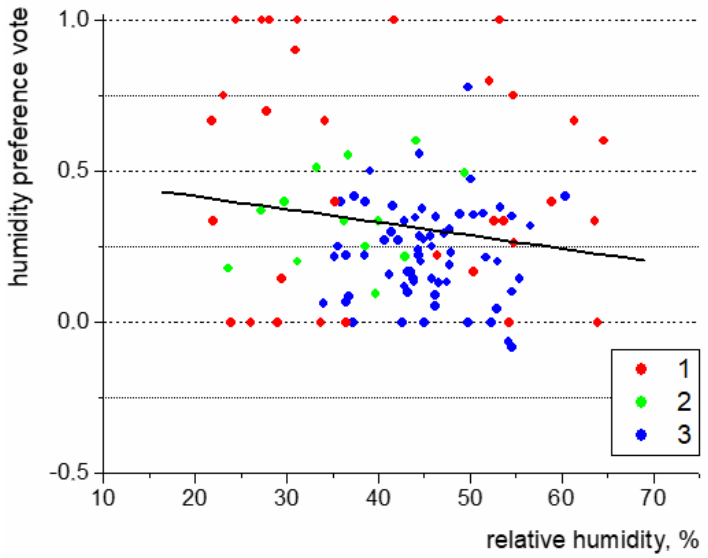
Figure 12. Humidity preference vote vs. relative humidity: in the Courthouse (1), “A” building (2) and “Energies” (3) with the best fit linear approximation of all the data represented by the black line.